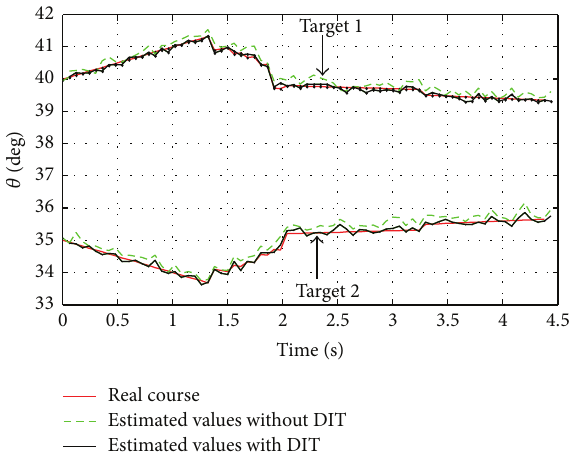
Figure 9: The moving target elevation angles during flight course.